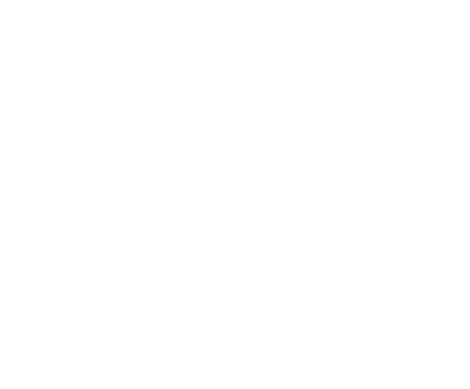
Table 3. E values of RL and LF2 calculated by the Ozawa method at different conversion rates.